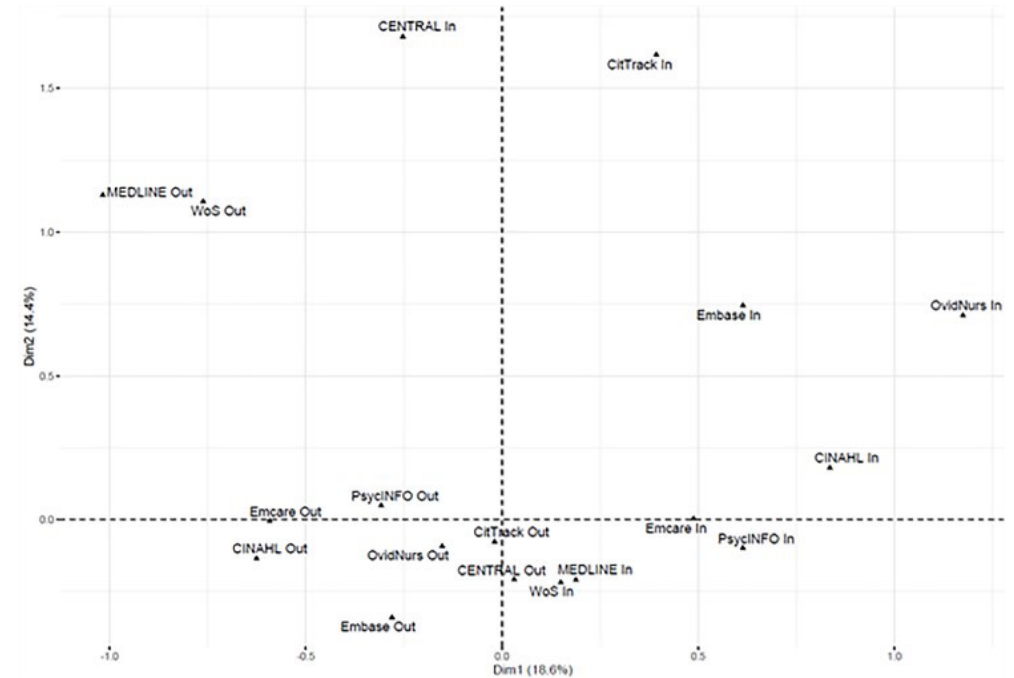
Figure 1 MCA map representing relations between databases indicated by indexed (In) and non-indexed (Out) cases